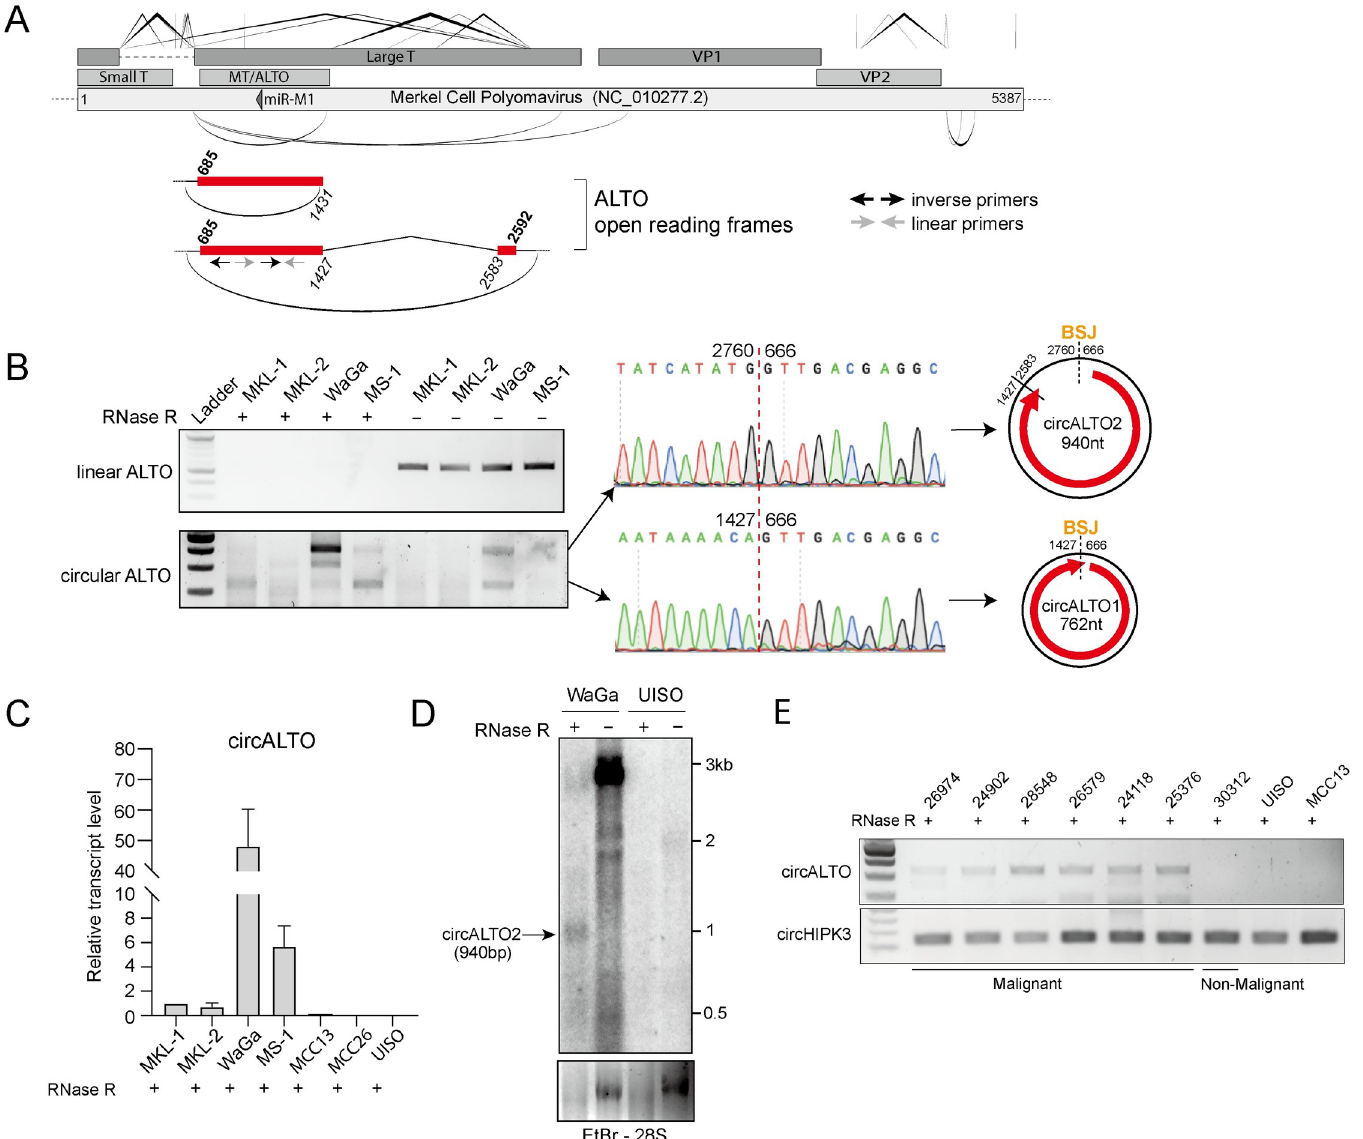
Fig 1. Identification of Merkel cell polyomavirus circRNAs. (A) (Top panel) Schematic representation of potential circRNAs identified by the vircircRNA for MCPyV. V-shaped lines above the map indicate forward splicing events. Elliptical arcs below the map indicate predicted backsplicing. (Bottom panel) Red rectangles indicate ALTO open reading frames. Bold numbers above the map indicate the first base of ALTO start and stop codons, italic numbers below the map indicate the positions of exon boundaries. (B) (Left panel) RT-PCR analysis of four VP-MCC cell lines (MKL1, MKL-2, MS-1 and WaGa) with and without RNase R treatment. (Middle panel) Sanger sequencing of inverse PCR products from WaGa cells confirmed the backsplice junction of the predicted circRNAs. (Right panel) Schematic of the two different circALTO forms, we termed circALTO1 and circALTO2 based on the product length. (C) qRT-PCR analysis for circALTOs from VP-MCC (MKL-1, MKL-2, MS1, and WaGa) and VN-MCC (MCC13, MCC26 and UISO) after RNase R treatment. ACTB served as the normalization control. Values are the mean of three technical replicates; bars represent standard deviation. (D) Northern blot of total RNA after with and without RNase R treatment from VP-MCC cell line WaGa and VN-MCC cell line UISO using an ALTO-specific probe. Arrow indicates RNase R resistant band consistent with circALTO2. (E) Endpoint PCR confirmed the presence of circALTO2 in patient MCC tumors (upper panel), but not a non-malignant skin control or VN-MCC cell lines. circHIPK3 served as a control for RNA integrity (bottom panel).